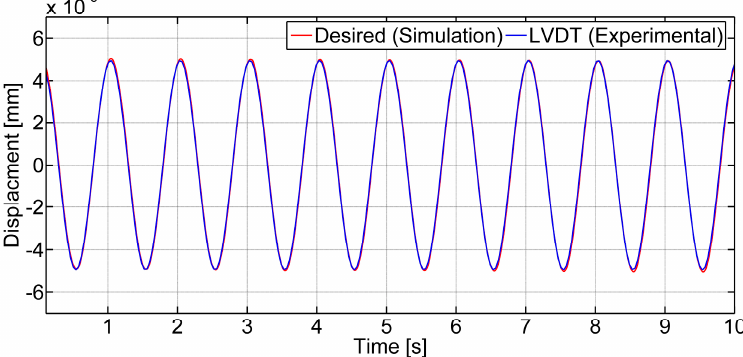
Figure 6. Desired and measured relative displacement comparisons.